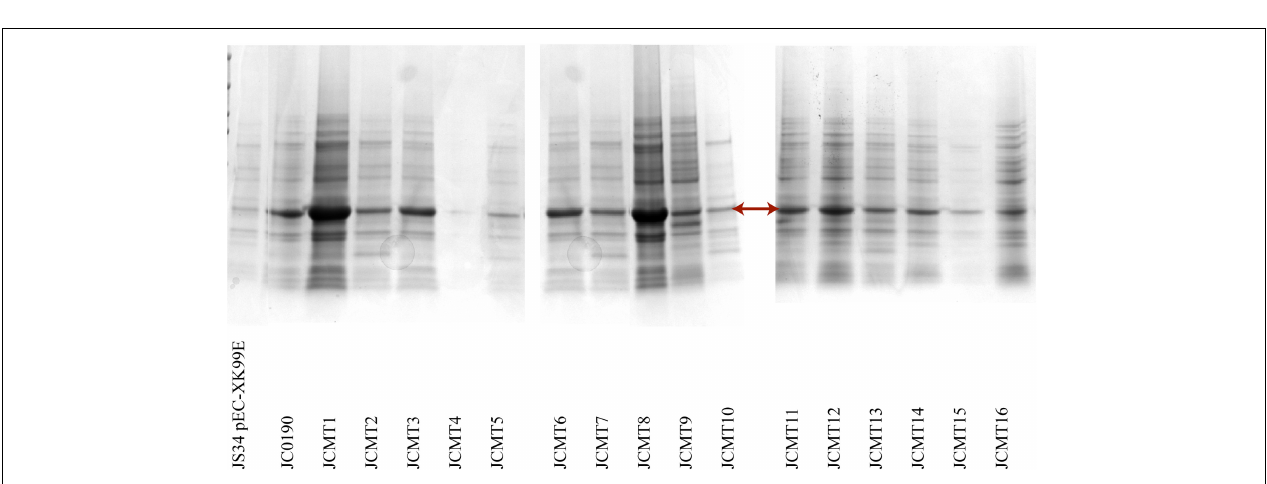
FIGURE 3 | Growth curves of the parent and mutant strains carried out in BioLector. The growth of the strains were monitored in a 48-well flower plate (culture volume: 1,000 µ L, temperature: 30 ◦ C, agitation: 800 rpm) by measuring scattered light (ex: 620 nm, Gain: 20).